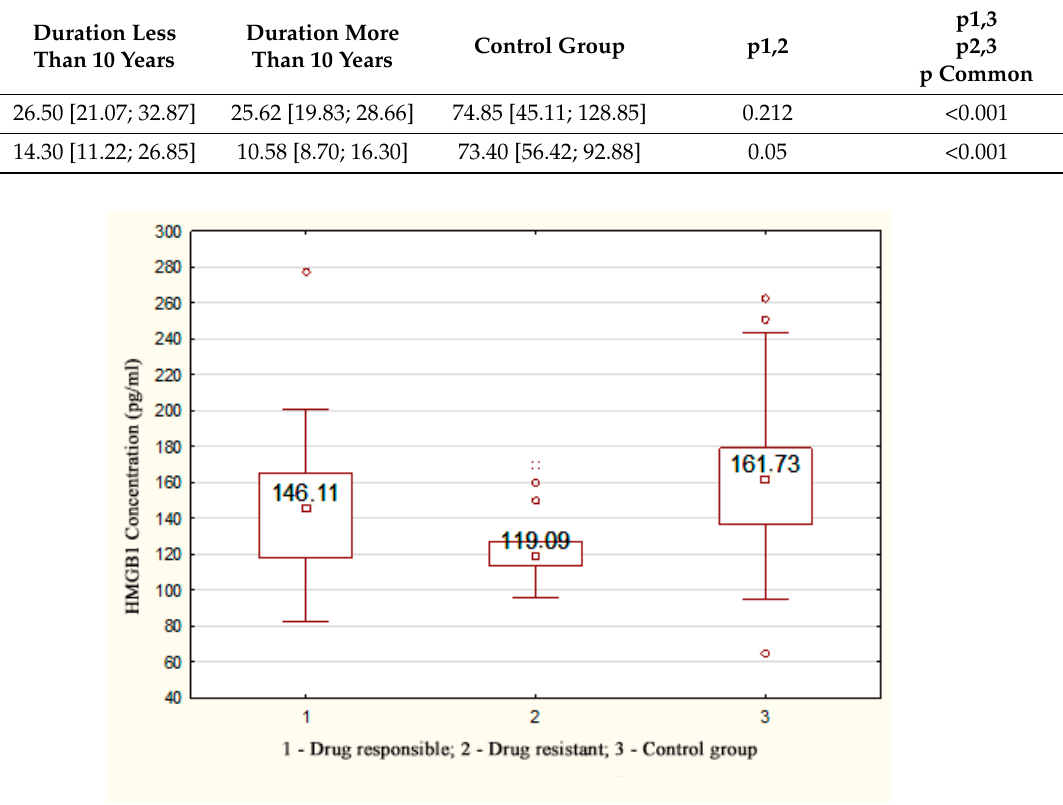
Figure 1. HMGB1 concentration depending on the response to therapy in patients with TLE.